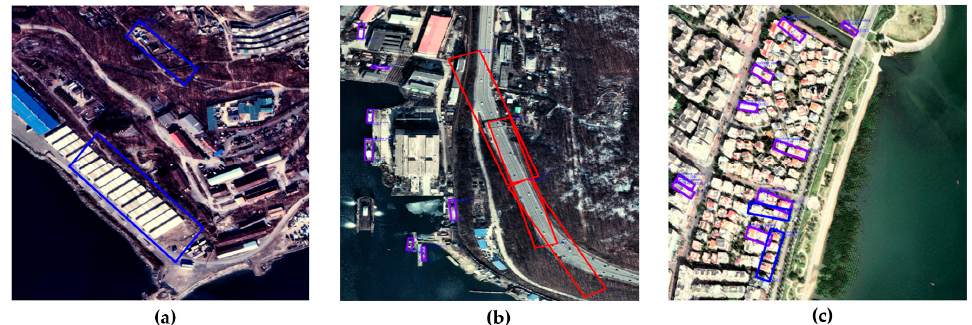
Figure 4. An object falsely detected as a ship within the land area. ( a ) False detection owing to container and topography; ( b ) False detection owing to highway; ( c ) False detection owing to building.